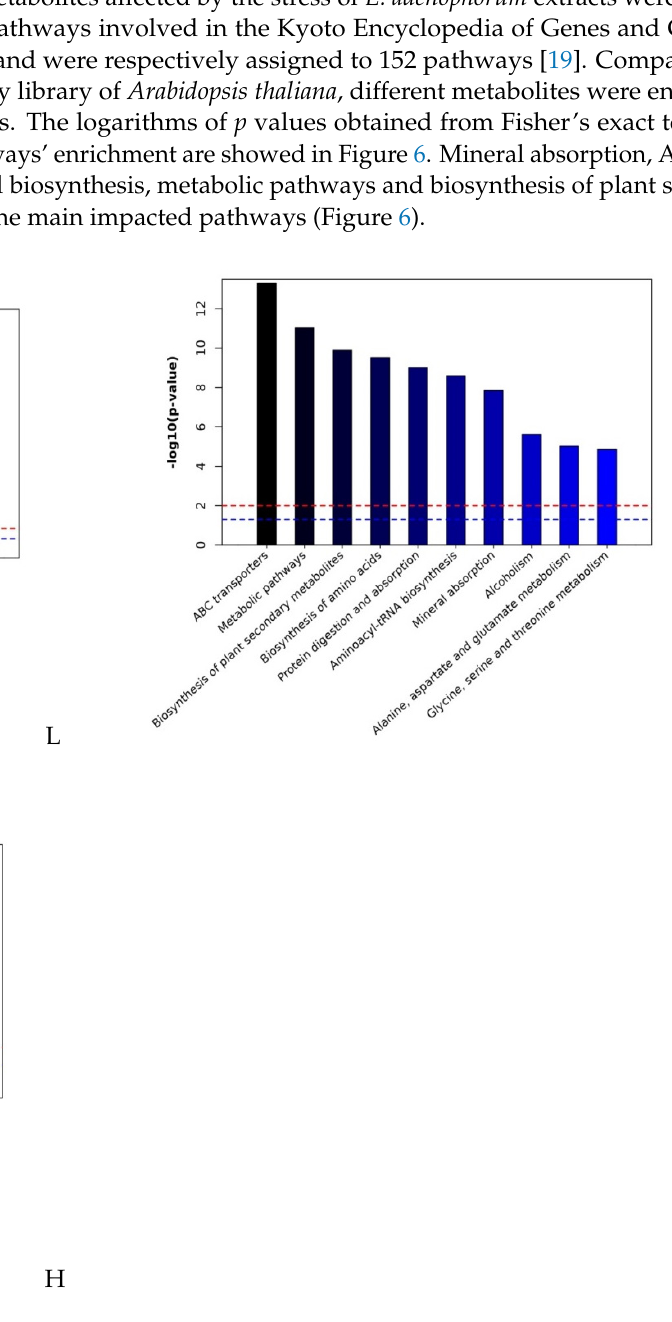
Figure 6. Histogram of the significances of biological pathways. Fisher’s exact test was performed to obtain the p value. The red dashed line represents p = 0.01. The blue dashed line represents p = 0.05. Data are from the impacted metabolites of A. thaliana treated by low concentration extract of E. adenophorum (L), medium concentration extract of E. adenophorum (M), and high concentration extract of E. adenophorum (H).